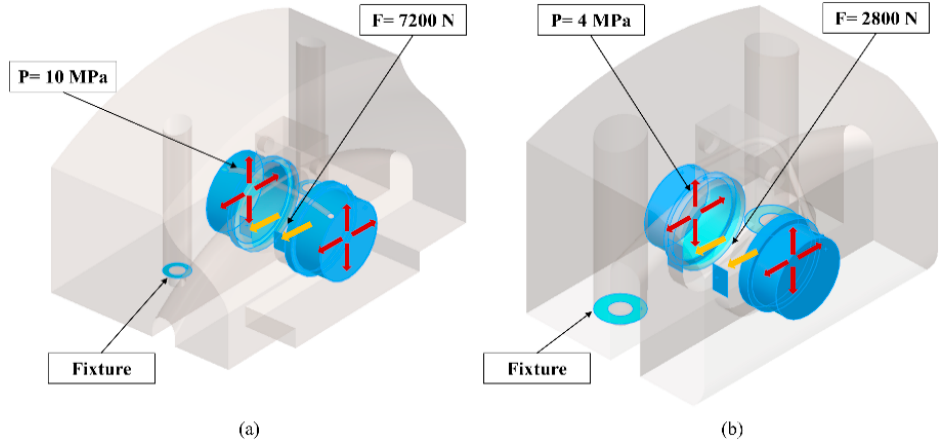
Figure 7. The design space, the loads, and the boundary conditions of the housings: ( a ) Housing of the front caliper, ( b ) Housing of the rear caliper.